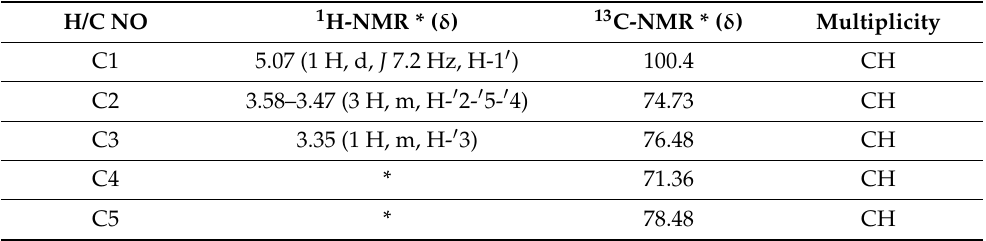
Table 3. 1 H and 13 C-NMR data for compound 2 * methanol CD 3 OD.